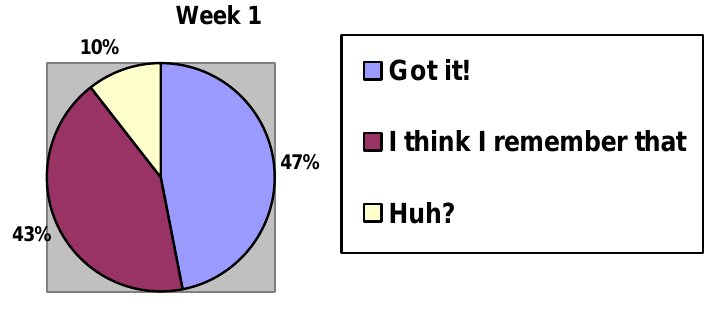
Figure 4. Student Comprehension Checklist from week one prior to implementation of posting and communicating daily learning